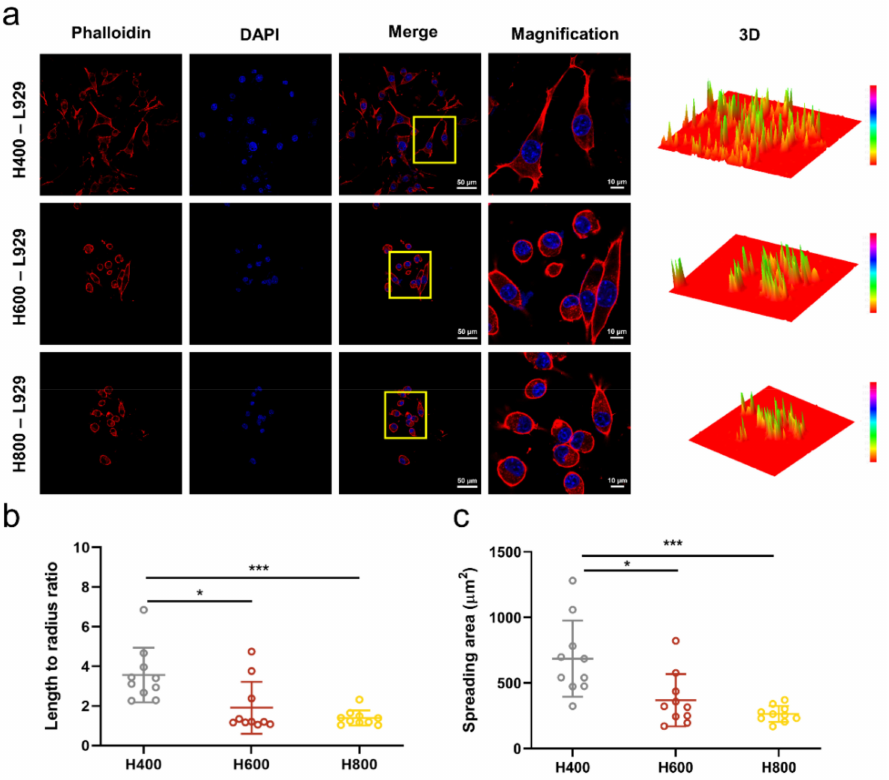
Figure 3. ( a ) Phalloidin/DAPI staining of L929 cells seeded onto nanofibers after 3 days and 3D reconstruction of red fluorescence by image J. ( b ) Quantification of cell length to radius ratio and ( c ) spreading area of L929 cells (n = 10). The yellow boxes indicate the magnification field of view (*** indicates p < 0.001, * indicates p <